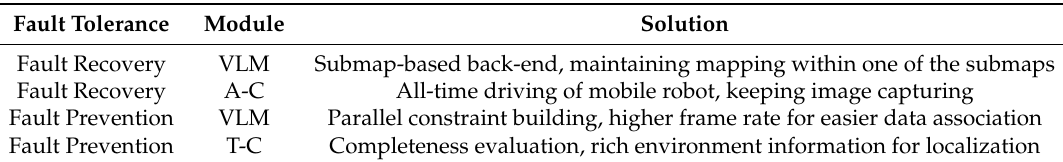
Table 1. Achievement of fault tolerance in all the modules within our proposed system, where VLM is the visual localization and mapping module, A-C is the Active Controller and T-C is the Termination